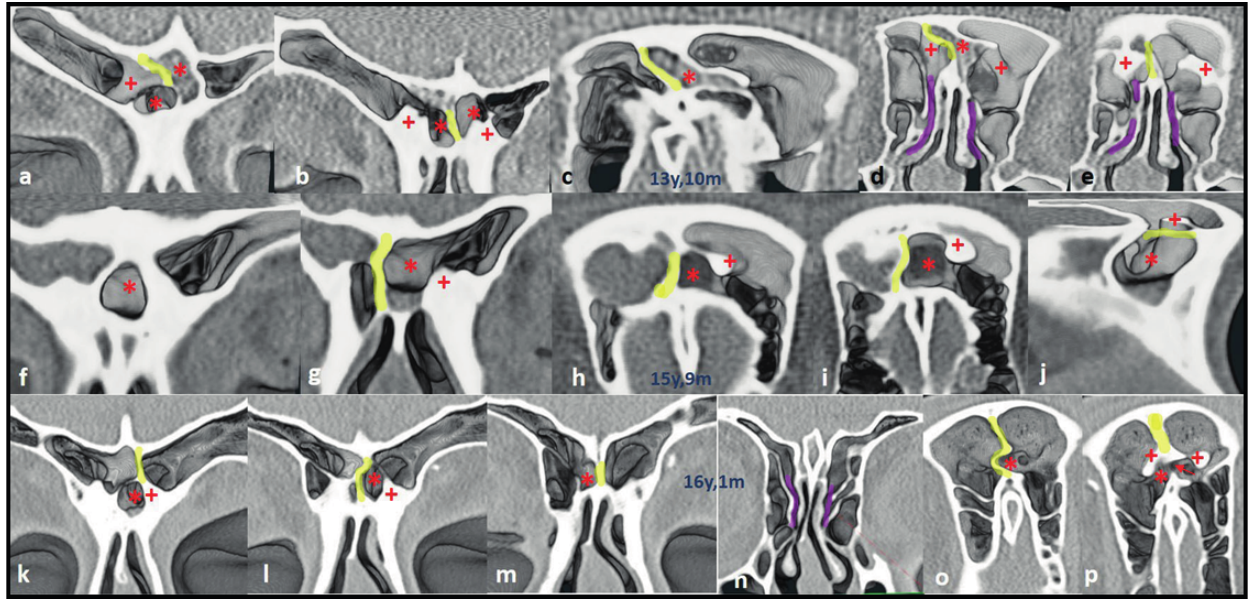
Figure 10. Frontal Inter-Sinus Septal Cell